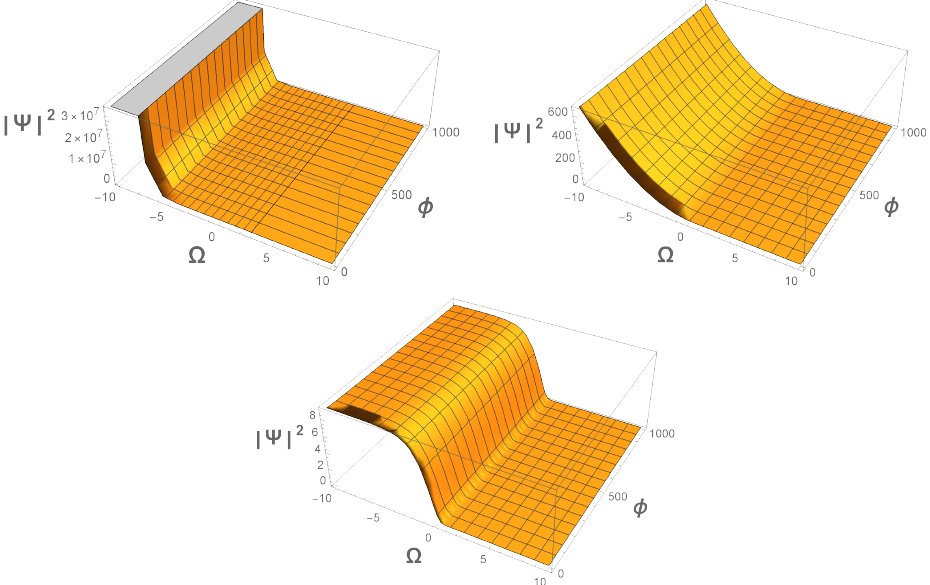
Figure 4. In the second case of the inflation-like scenario, corresponding to Equation (53), the behavior for the probability density in terms of the Mittag–Leffler function with complex values in its argument z is shown, for Q = − 1,0,1. From top to bottom, respectively, we consider the value for the parameter µ = 0.5. In these graphs, we use the Re[z] only; however, the plots with Im[z] are